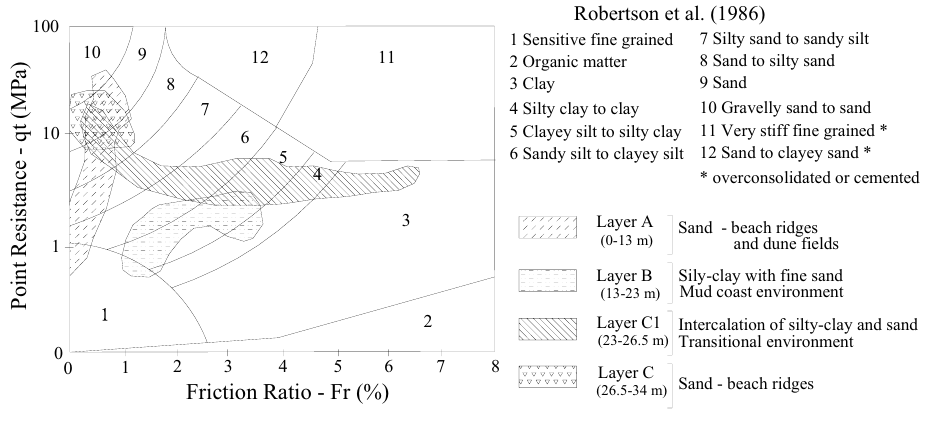
Fig. 8 – Interpretation of resistivity piezocone test results for stratigraphic logging and the depositional environmental conditions in Paranaguá site sediments. (De Mio et al. 2005).